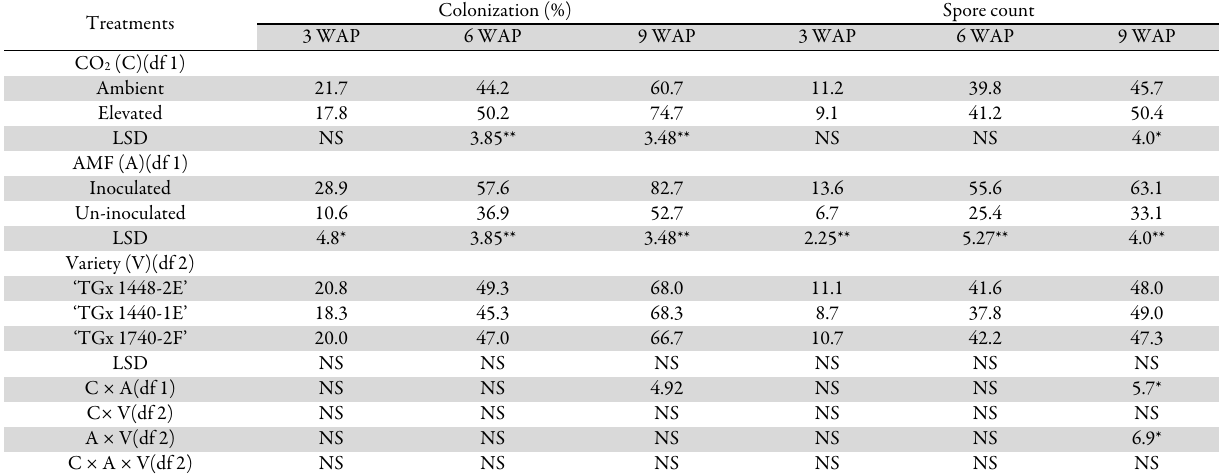
Table 5. Effect of CO 2 elevation and AMF inoculation on percentage mycorrhizal colonisation and AMF sporulation of soybean varieties at 3, 6 and 9 WAP (Field